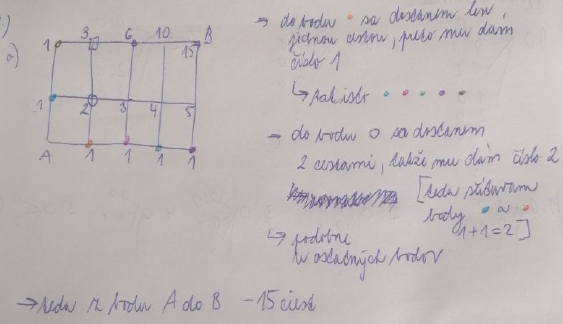
Figure 10. Part of Pascal triangle in the solution of task 3.2